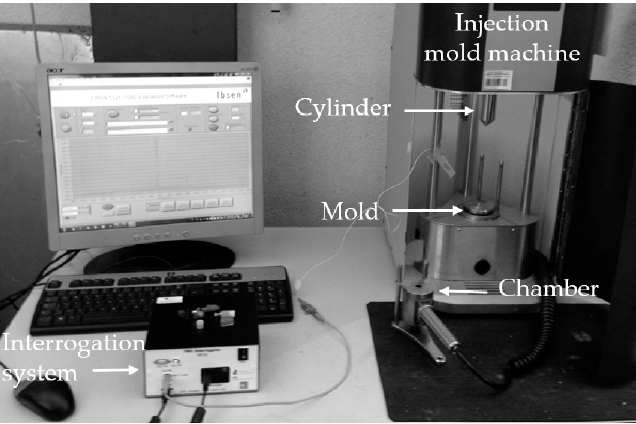
Figure 3. Experimental setup implemented to embed the FBG sensors and monitor the injection cycles.